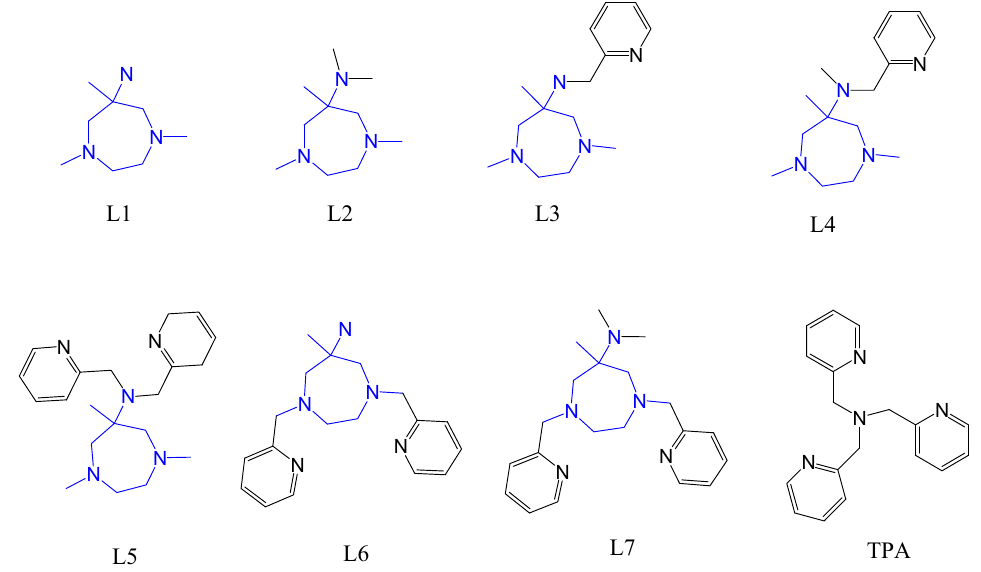
Figure 14. Non-Me 3 TACN Ligands tested with Mn and Fe salts towards alkyd resin curing.